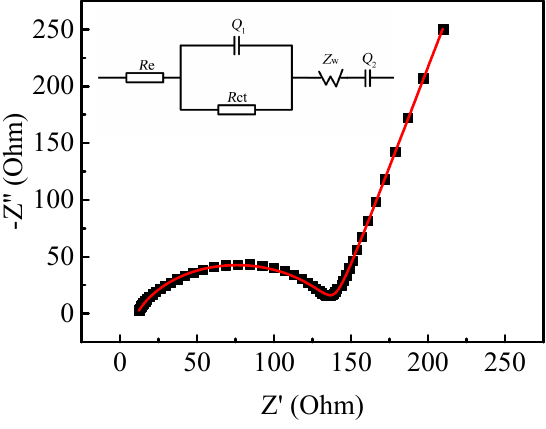
Figure 10. Electrochemical impedance spectra of the prepared LiMnPO 4 /C. Table 2. Parameters of EIS spectroscopy of the prepared LiMnPO 4 /C.